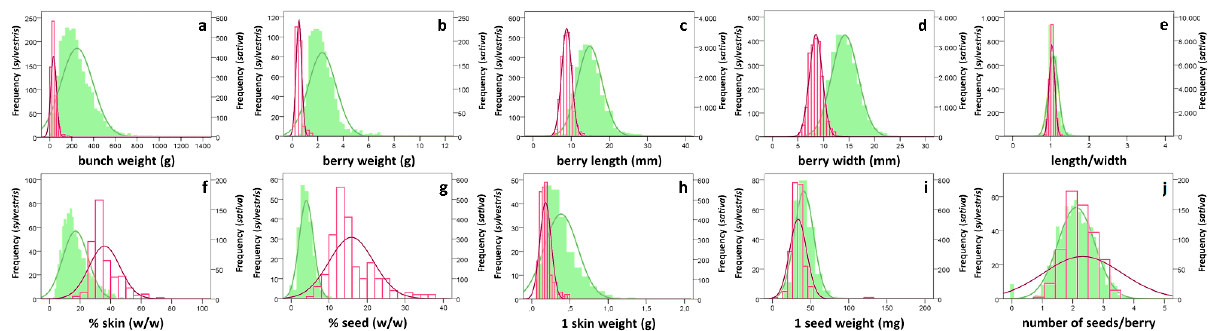
Figure 1. Carpological characteristics of Vitis vinifera subsp. sylvestris (in pink) and subsp. sativa (in green). Vitis vinifera subsp. sativa data are already published in Rustioni et al. [26]. ( a ): bunch weight (g), ( b ): berry weight (g), ( c ): berry length (mm), ( d ): berry width (mm), ( e ): length/width, ( f ): % skin ( w/w ), ( g ): % seed ( w/w ), ( h ): one skin weight (g), ( i ): one seed weight (mg), ( j ): number of seeds/berry.